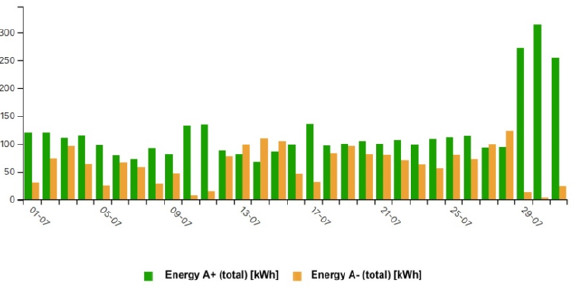
Figure 3: Graph of energy consumed (A+) and donated (A − ) in Sector 5 LSTP in the month of July